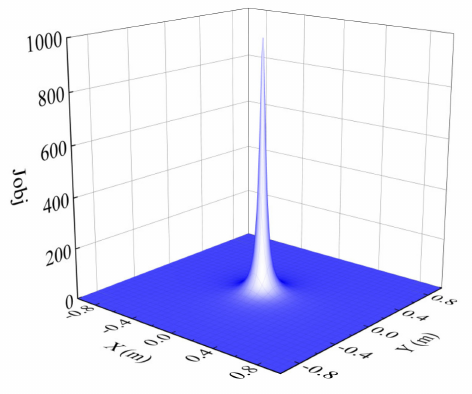
Figure 3. Obstacle avoidance